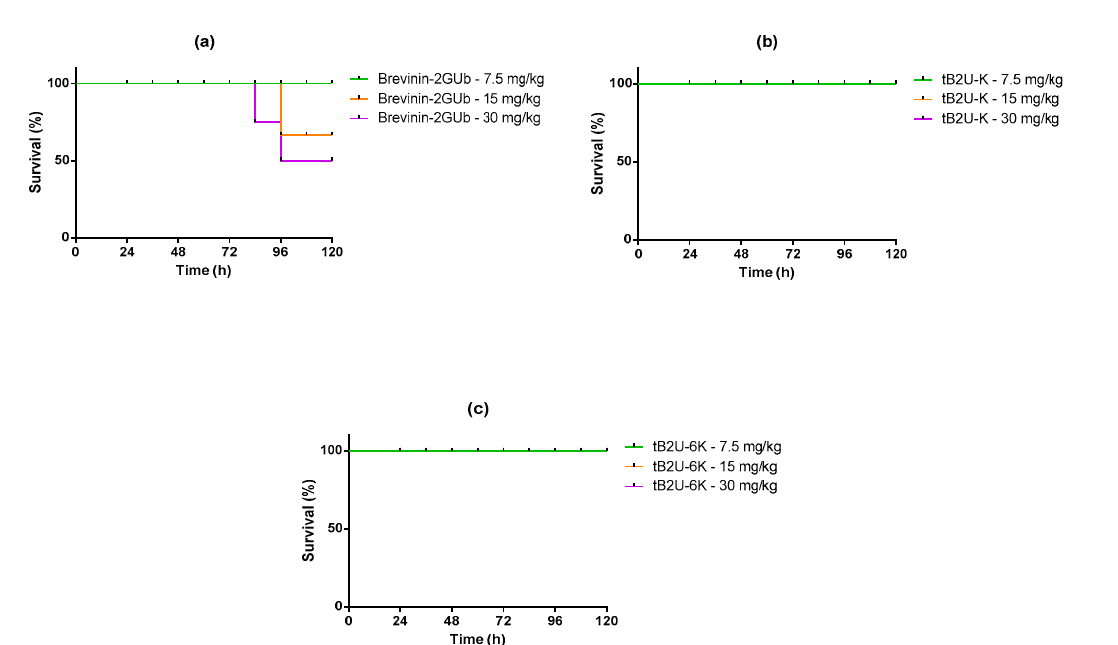
Figure 8. The curves of the survival rate of the waxworms treated with ( a ) Brevinin-2GUb, ( b ) tB2U-K and ( c ) tB2U-6K, separately.